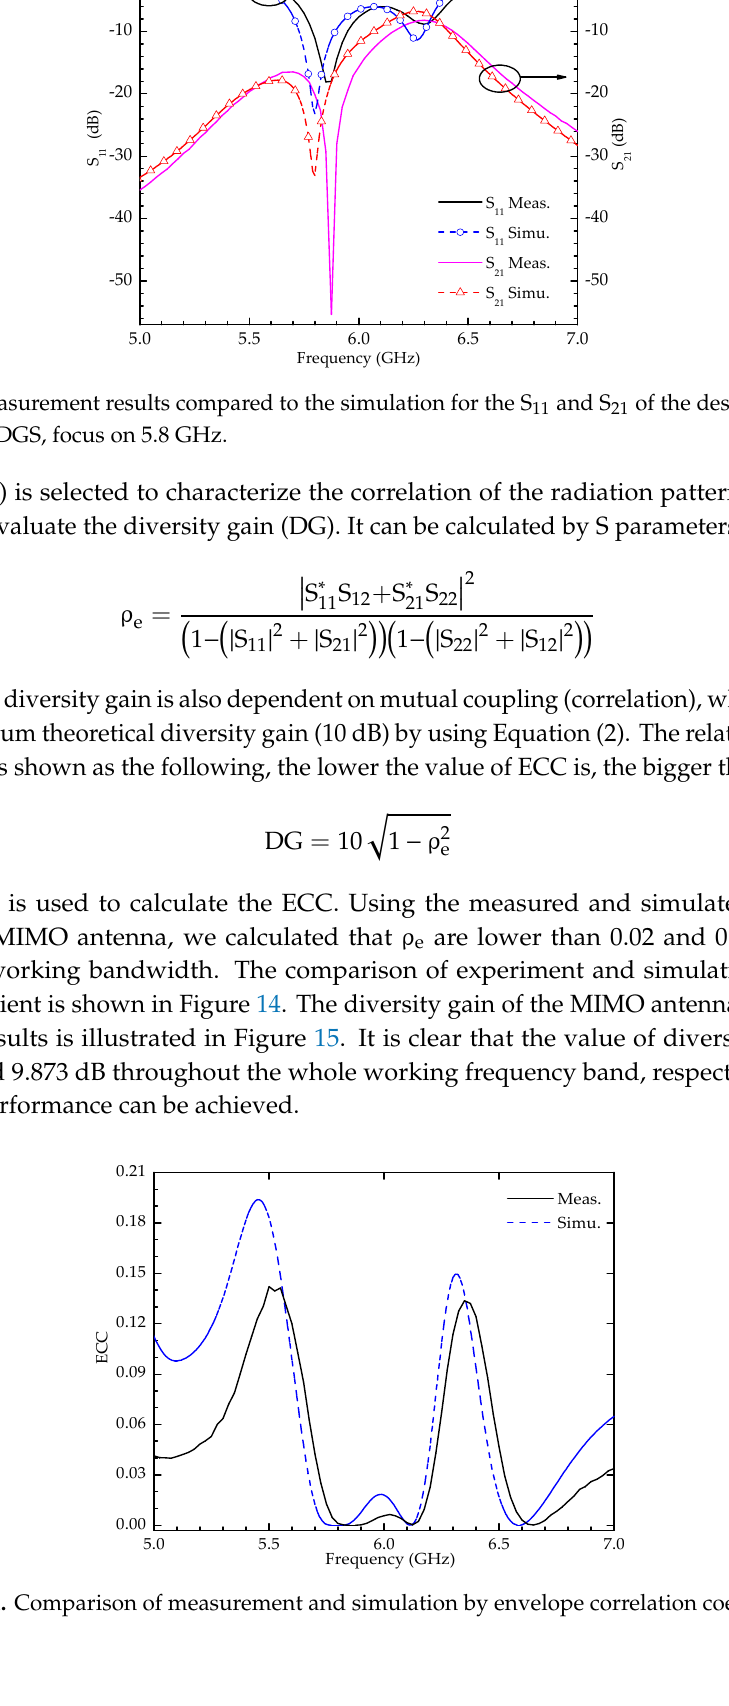
Figure 14. Comparison of measurement and simulation by envelope correlation coefficient.